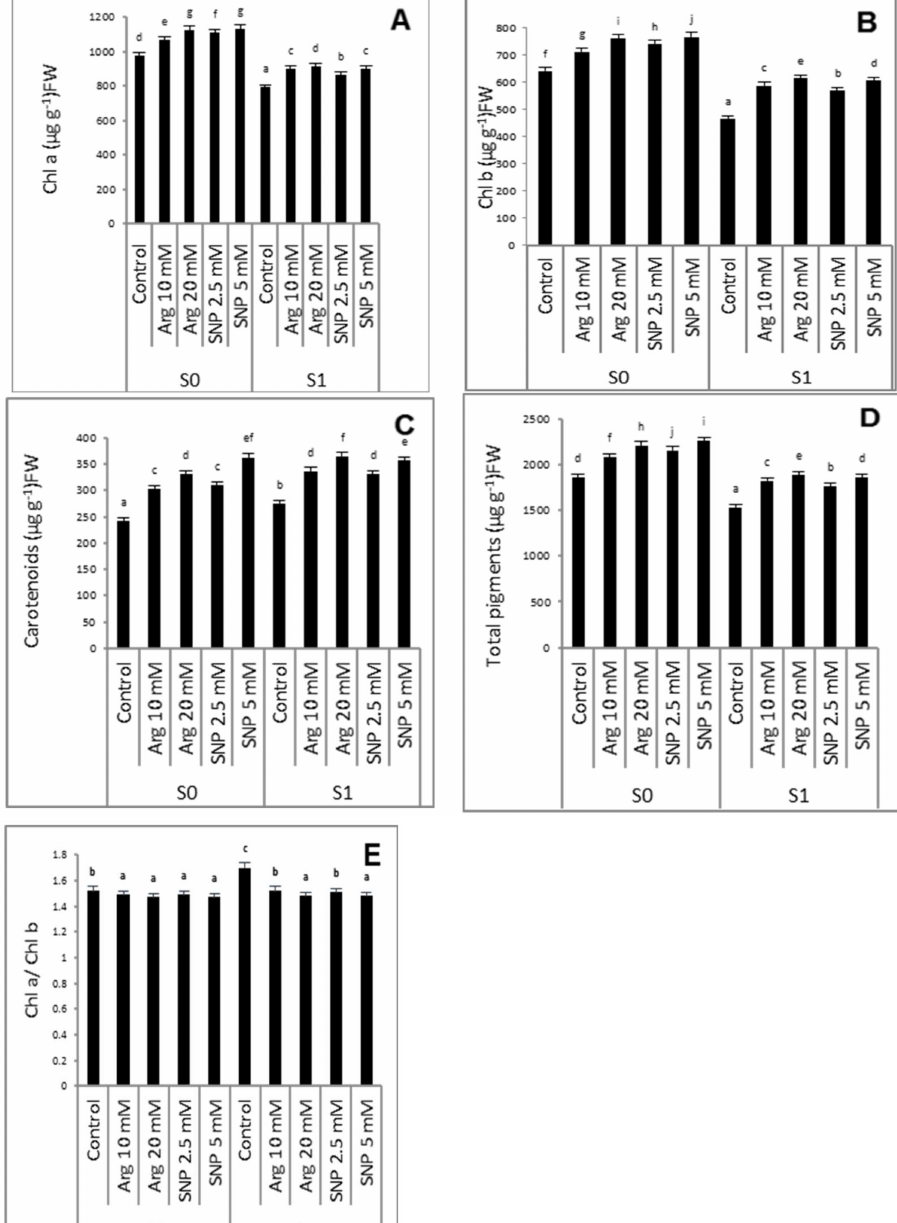
Figure 1. Effect of arginine or SNP on photosynthetic pigments indices of wheat plants (chlorophyll a ( A ), chlorophyll b ( B ), carotenoids ( C ), and total pigments ( D ), chlorophyll a/chlorophyll b ( E )) under salinity stress. S 0 = 1.2 mM NaCl, S 1 = 85.5 mM NaCl. All the statistical differences were presented relative to the untreated control. Data are means of three replicates ± SE; means with different letters are significantly different ( p ≤